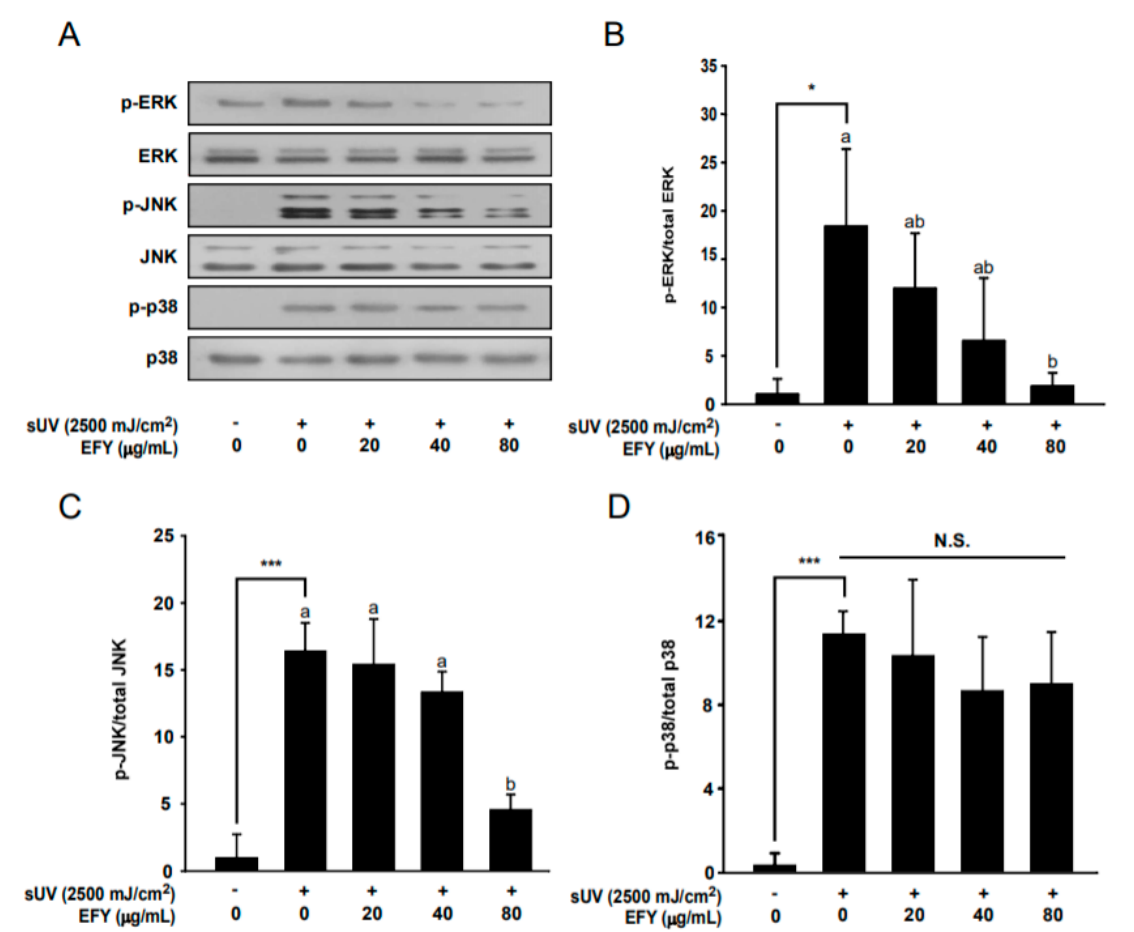
Figure 4. EFY inhibits sUV-induced phosphorylation of ERK1/2 and JNK1/2 but not p38. ( A ) EFY reduces sUV-induced phosphorylation of ERK1/2 and JNK1/2 in HaCaT cells. ( B – D ) Quantification of sUV-induced phosphorylated MAPKs in HaCaT cells without the presence and absence of EFY. Each phosphorylated form of the MAPK proteins was normalized to the corresponding total form of the proteins. Data ( n = 3) are mean values ± SD. * significant difference ( p < 0.05) and *** significant difference ( p < 0.001) between the control and sUV-exposed control. N.S., not significant. Mean values with different letters indicate statistically significant differences among sUV-exposed groups ( p < 0.05). Representative western blots from three independent experiments are shown ( n = 3).